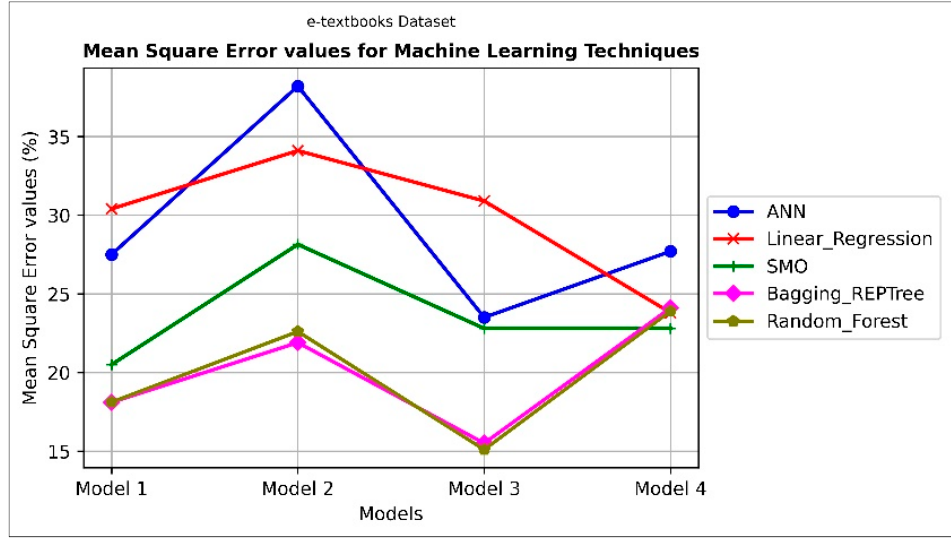
Figure 2. Mean square error values for ML.